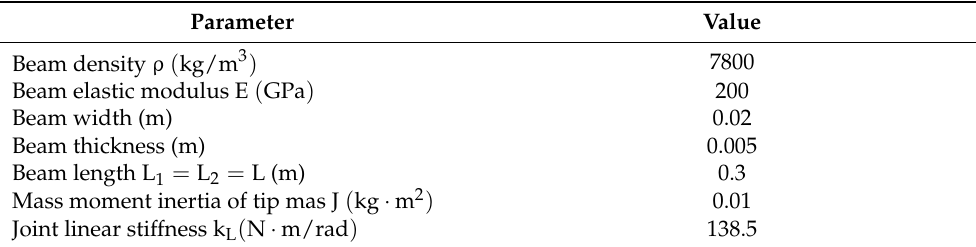
Table 1. Values of the parameters of the L-shaped multi-beam jointed structure.